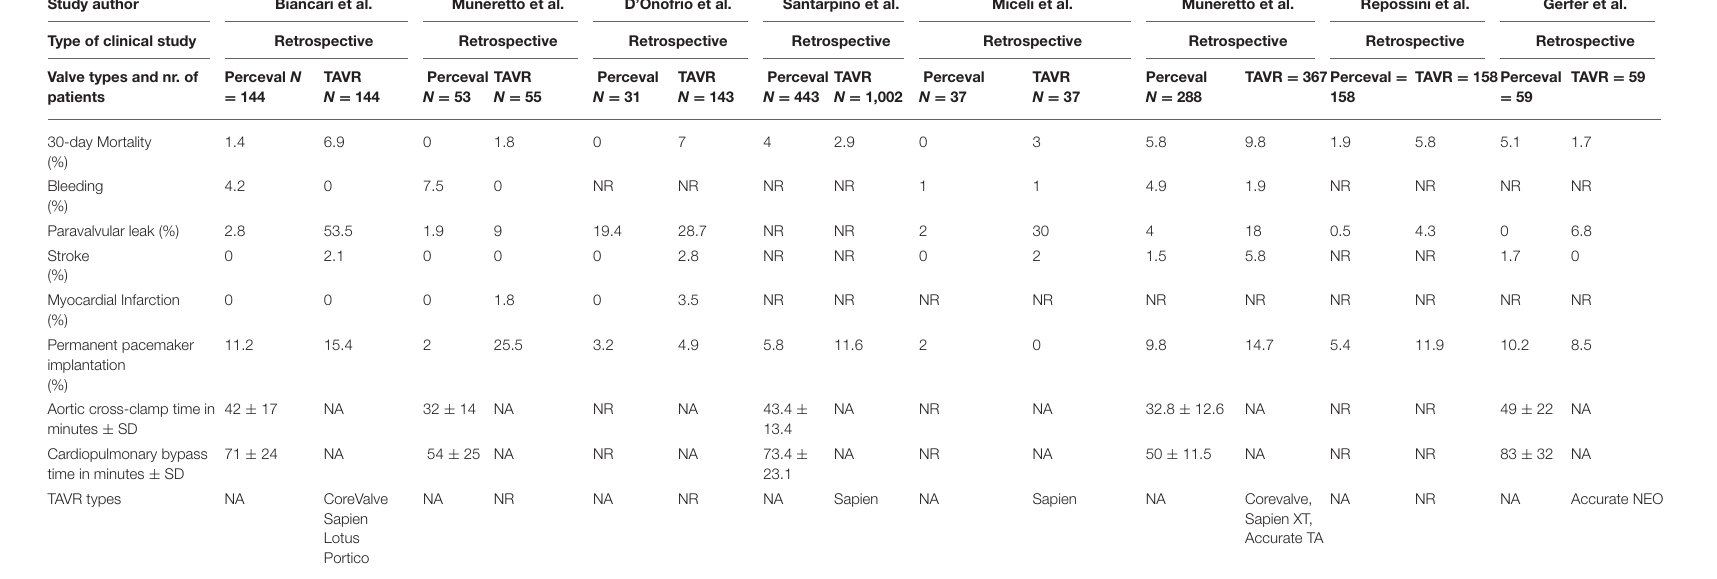
TABLE 1 | Sutureless aortic valve replacement vs. transcatheter aortic valve